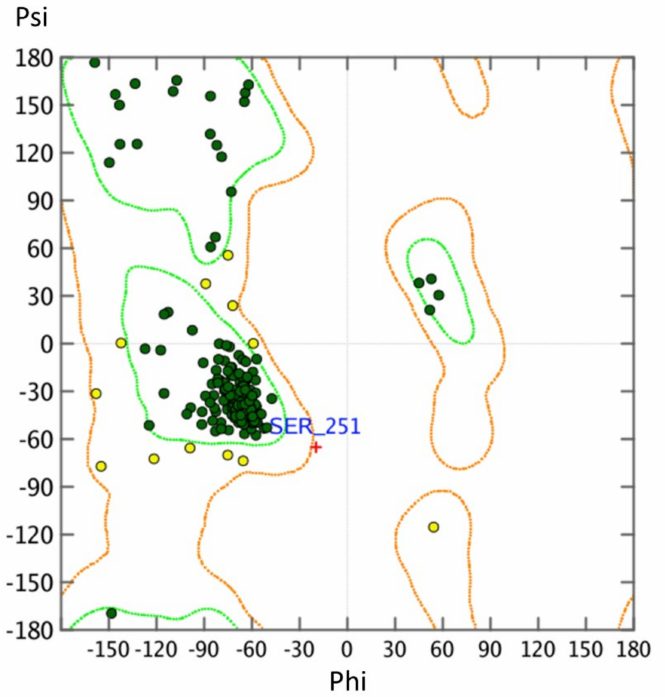
Figure 3. Ramachandran plot of the NOP receptor homology model. Angles within the orange range angles are plausible (yellow spheres) and angles within the green space are optimal (green